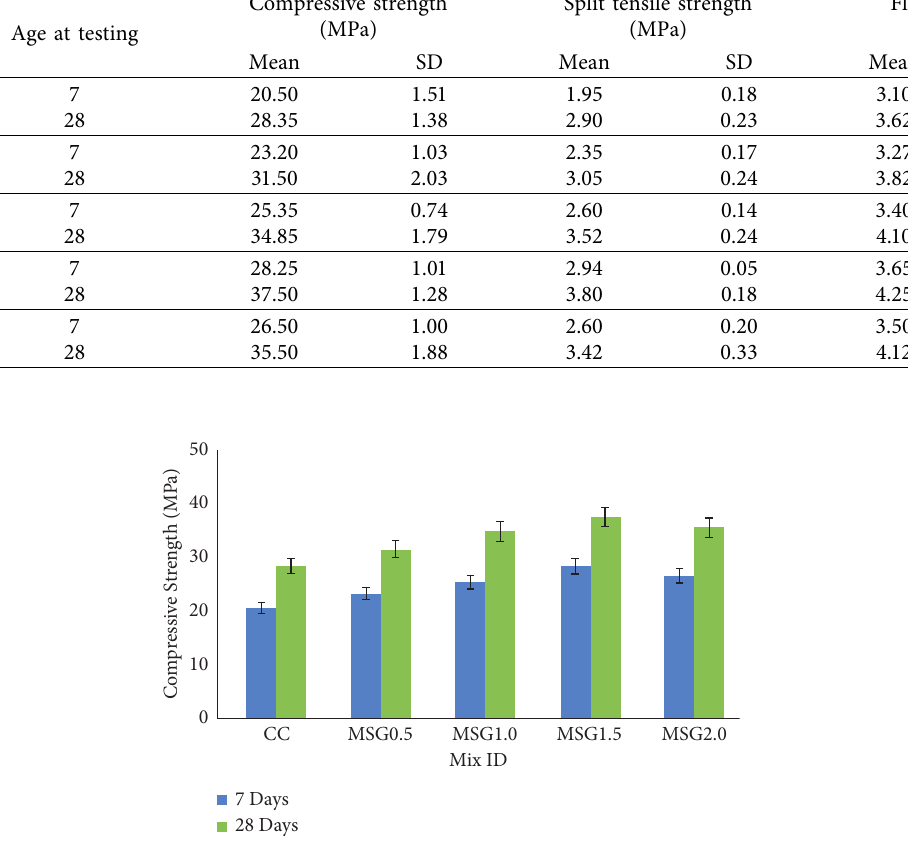
Figure 6: Compressive strength of various mixes.